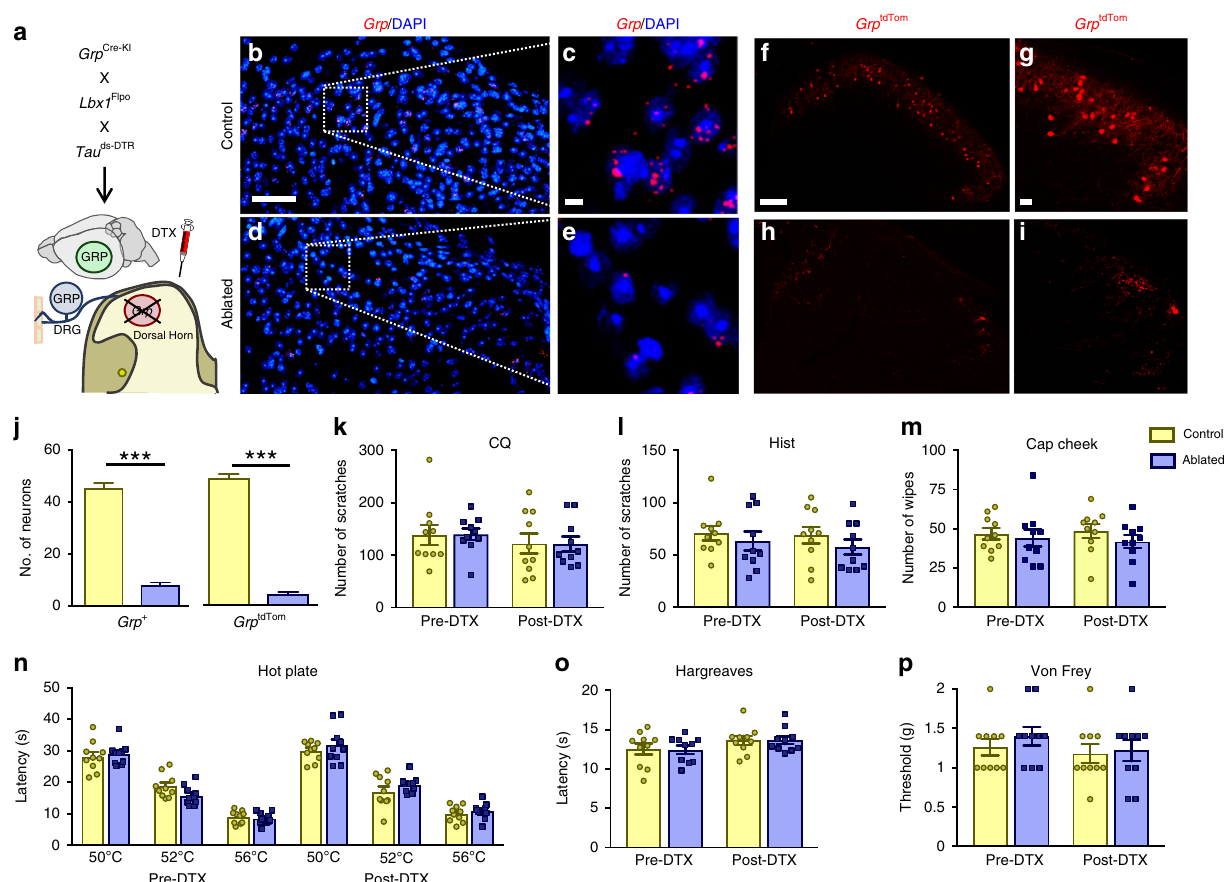
Fig. 7 Intersectional ablation of Grp spinal neurons does not affect itch or pain behavior responses. a Schematic of mating strategy of Grp Cre-KI with Lbx1 Flpo and Tau ds-DTR lines to generate DTR-expressing Grp spinal neurons and subsequent DTX injection to ablate Grp spinal neurons. b – e ISH images of Grp expression in cervical spinal cord sections from ( b , c ) control and ( d , e ) ablated littermates. Scale bars, 100 μ m in b and 20 μ m in c . f – i Epi fl uorescent images of tdTomato in cervical spinal cord sections from ( f , g ) Grp tdTom control and ( h , i ) Grp tdTom ablated mice. Scale bars, 100 μ m in f and 20 μ m in g . j Mean number of Grp + neurons and Grp tdTom neurons in control and ablated sections. n = 3 mice and 10 sections, unpaired t test, *** p < 0.001. k , l Mean number of scratches induced by i.d. nape injection of ( k ) CQ (100 μ g) and ( l ) Hist (200 μ g) in control and ablated mice pre- and post-DTX